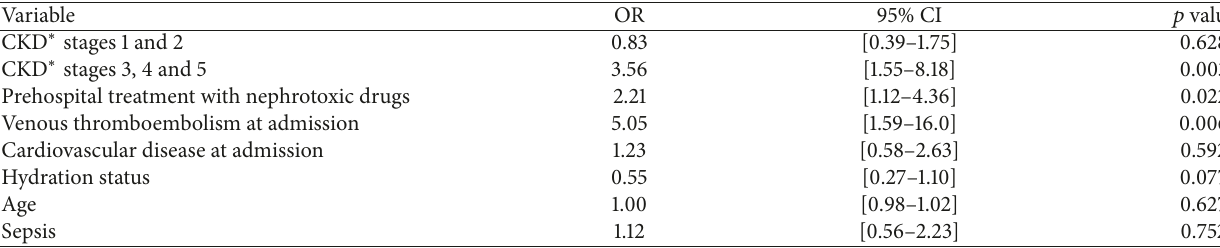
Table 3: Risk factors associated with EAKI, multivariate